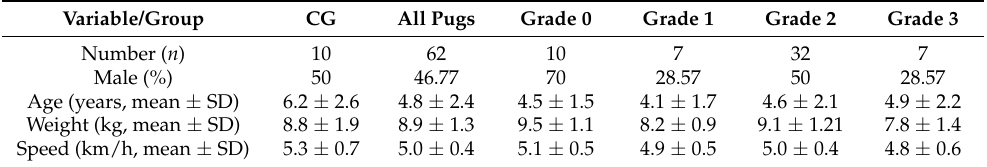
Table 4. Baseline characteristics of included dogs. Characteristics were reported for dogs in the control group (CG), all pugs, and pugs divided into the BOAS groups (grades